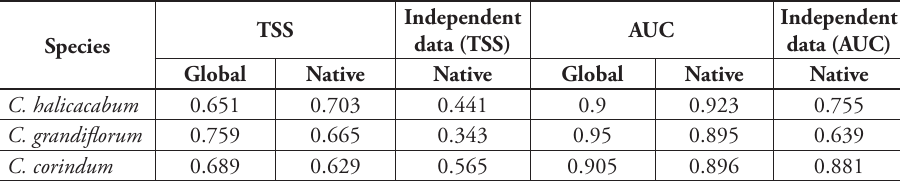
Table 3. Evaluation of modelling predictions. True skill statistic (TSS) and area under the receiver operating characteristic (ROC curve) (AUC) for global and native range modelling of three widespread Cardiospermum species. The first value in TSS and AUC column is for global and the second for native range modelling. Independent data evaluation is for the native range models evaluated against known non-native